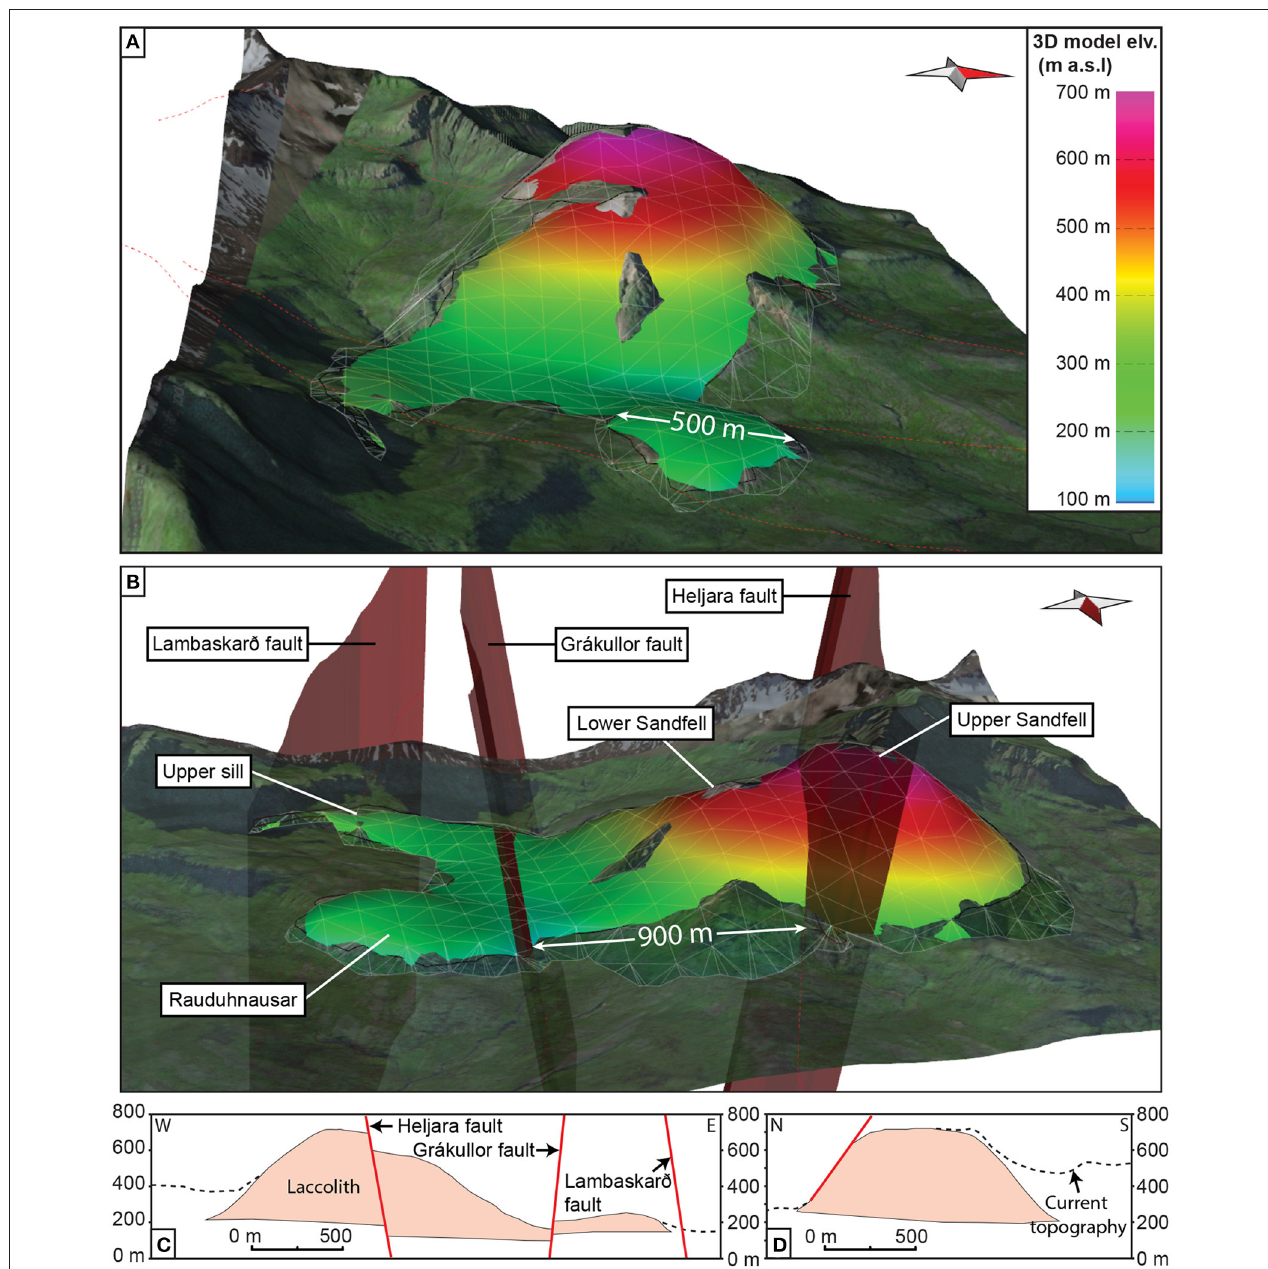
FIGURE 3 | (A,B) 3D reconstruction of the Sandfell laccolith prior to erosion. The regional faults are visualized as red transparent planes in (B) . The topographic surface is based on data from National Land Survey of Iceland. (C) E-W cross-section of the reconstructed Sandfell laccolith through Rauduhnausar and the main body. Displacement on the Heljara fault ranges between 120 and 75m and about 80m displacement is recorded on the Grákullor fault in the vicinity of the Sandfell laccolith (Gibson, 1963). (D) N-S cross-section through the reconstructed Upper Sandfell. The northern contact of the Sandfell laccolith is probably faulted (Hawkes and Hawkes,